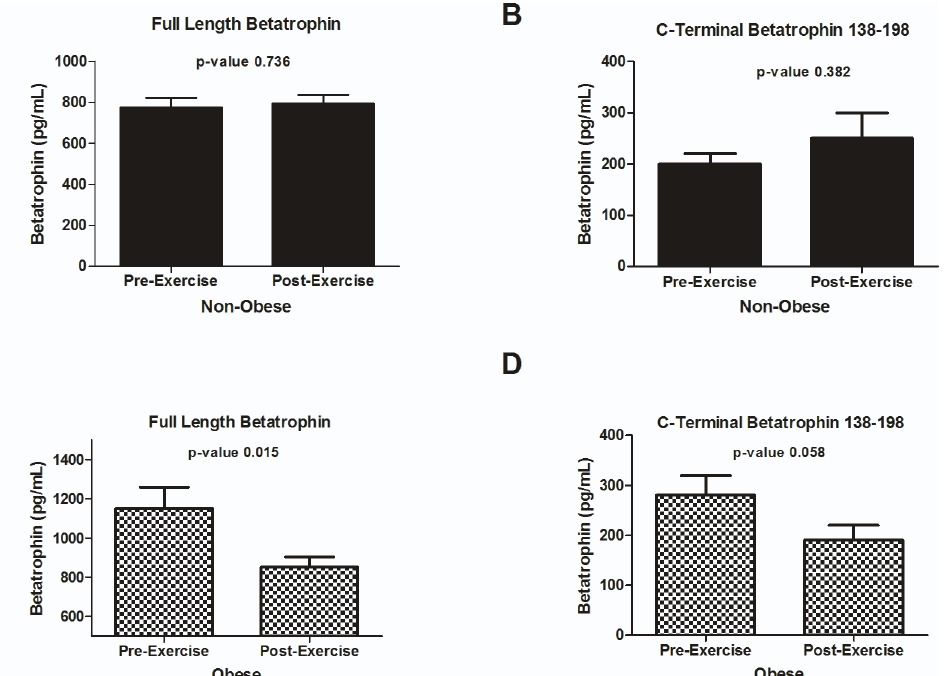
Fig 2. ANGPTL8 level after exercise. A : Level of full length form of ANGPTL8 in non-obese subjects before and after three months of exercise training. B : Level of C-terminal 139 – 198 form of ANGPTL8 in non-obese subjects before and after three months of exercise training. C : Level of full length form of ANGPTL8 in obese subjects before and after three months of exercise training. D : Level of C-terminal 139 – 198 form of ANGPTL8 in obese subjects before and after three months of exercise training.